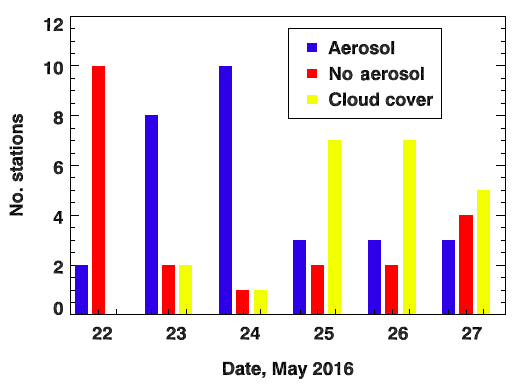
Figure 6. The number of Lufft ceilometers that observed distinct layers of aerosol (blue), trace amounts or no aerosol (red), or were obscured by clouds (yellow) for the period 22 to 27 May 2016.